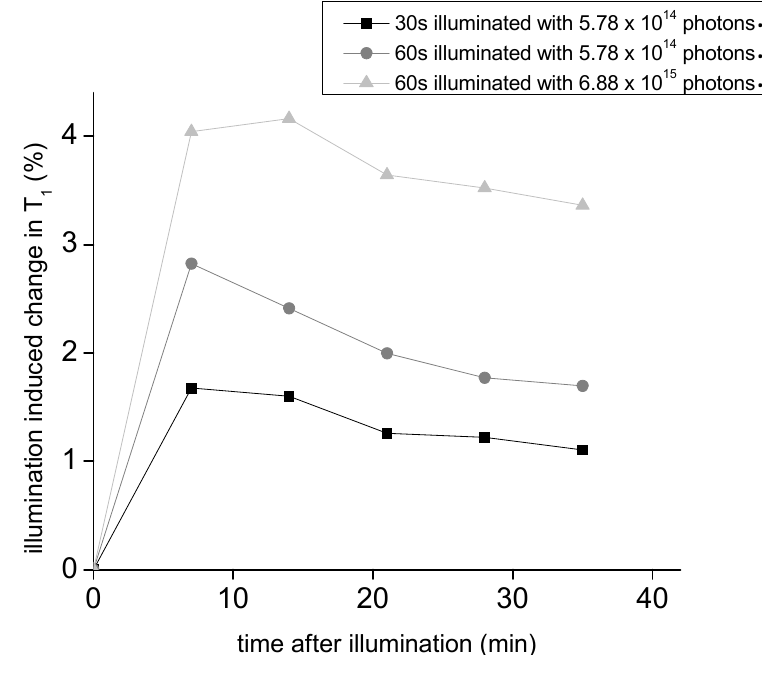
Figure 5. Relaxometric properties of spiropyran-DO3A-Gd in water: Determination of the relaxometric properties in response to light stimulation was performed with spiropyran-DO3A-Gd in water solution after brief light